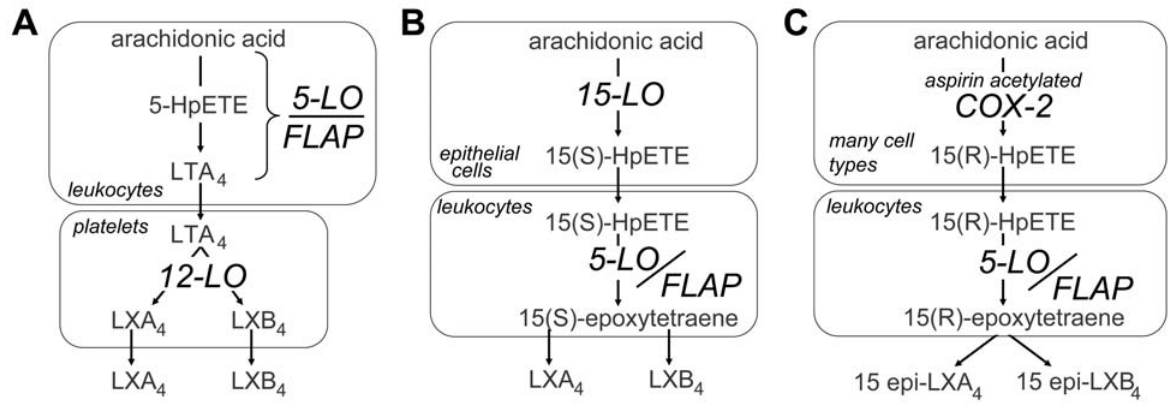
FIGURE 4. Biosynthesis of lipoxins. Lipoxins can be produced during cell-cell interactions, utilizing enzymes in adjacent cells. Either LXA 4 or LXB 4 can be synthesized from AA by either (A) a 5-LO/FLAP to 12-LO pathway or (B) a 15-LO to 5-LO/FLAP sequence. (C) Aspirin-triggered lipoxins are sequential action of aspirin acetylated COX-2 and 5-LO/FLAP on